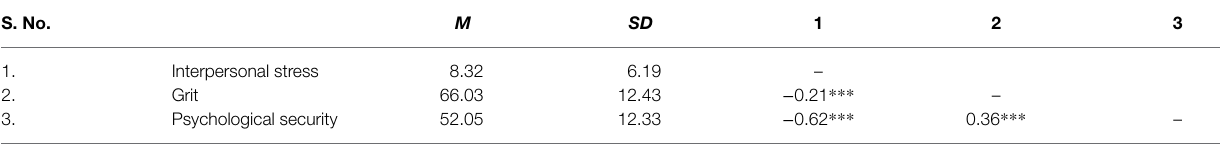
TABLE 1 | The mean ( M ), standard deviation ( SD ), and correlations of main variables in Study 1. S.